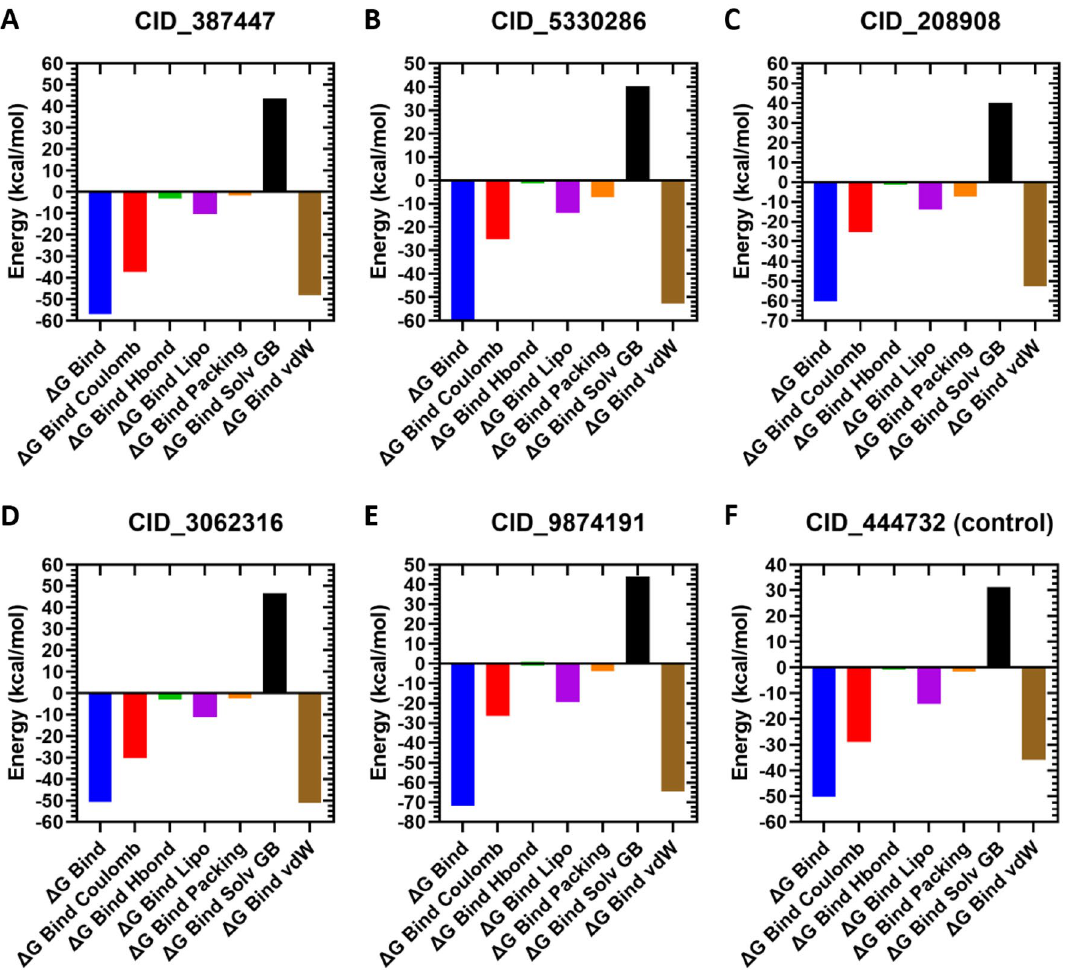
Figure 3. MM-GBSA binding free energy values of the selected docked compounds were comparison with